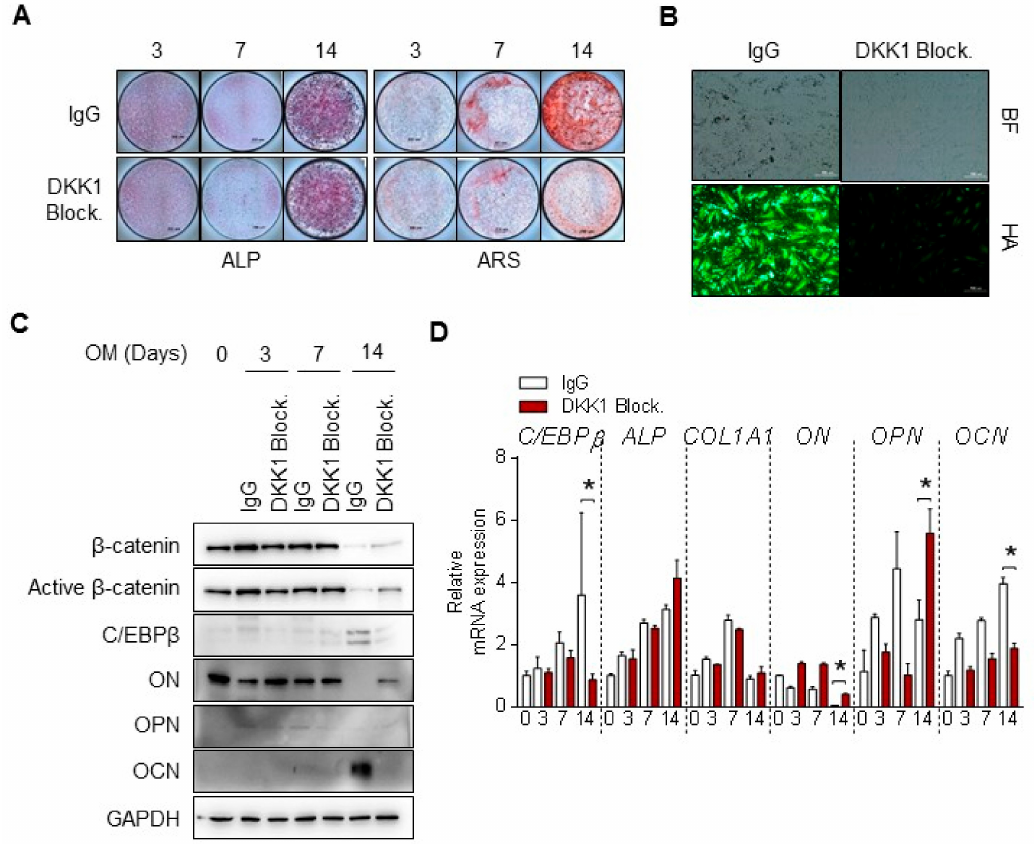
Figure 5. DKK1 blockade inhibits mineralization of osteoblast di ff erentiation. Osteoblasts were treated with 1 µ g anti-DKK1 or IgG as controls during osteoblast di ff erentiation ( n = 3). At indicated days, analysis of ( A ) results of ALP and ARS staining; scale bar is 200 µ m, ( B ) hydroxyapatite staining; BF, Bright Field; HA, Hydroxyapatite; Scale bar is 500 µ m, ( C ) immunoblotting for proteins, and ( D ) qPCR for mRNA. Representative data are shown ( n = 3). * p < 0.05 (mean ± SD; n =